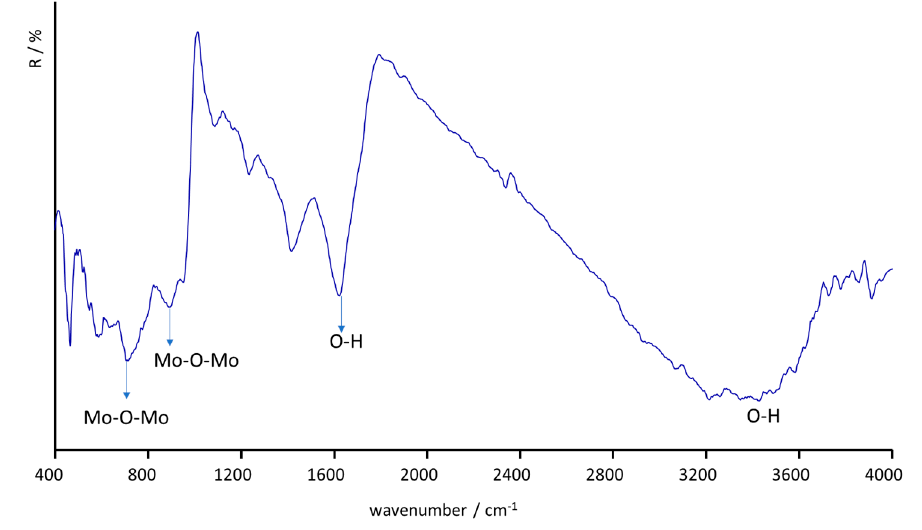
Figure 3. Vibrational Fourier-Transform Infrared (FTIR) spectrum of the calcined MoO 2 NPs.